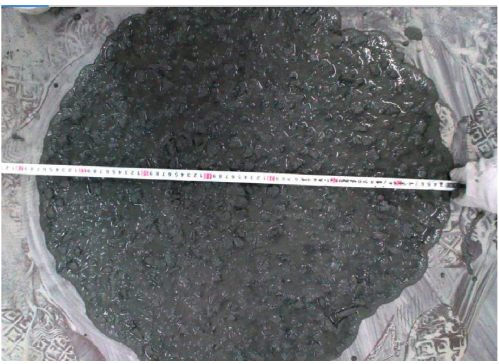
Figure 2: Slump flow of fresh SFRSCC. Table 2: Workability of